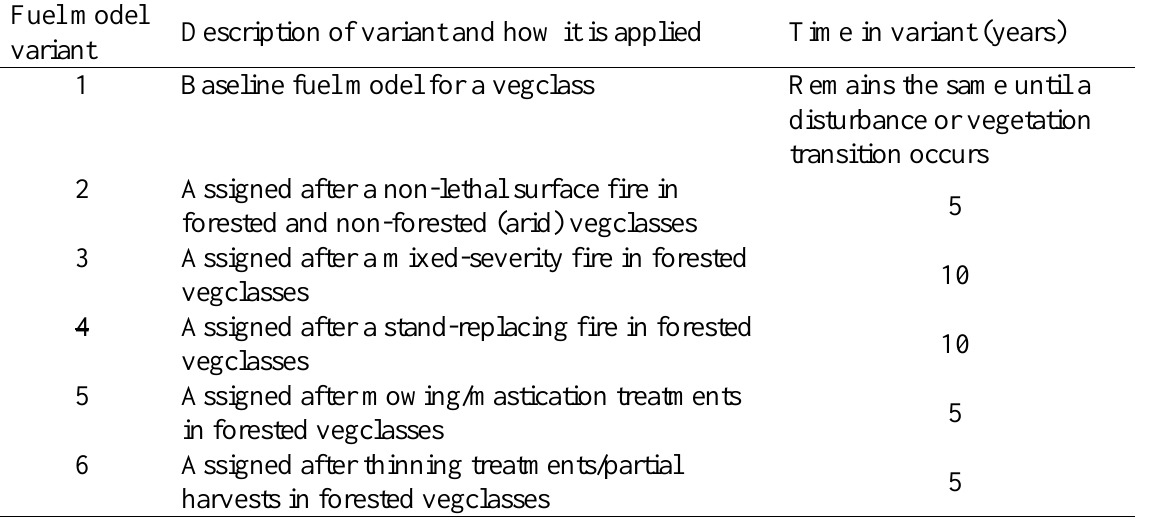
Table A2.2. Description of fuel model